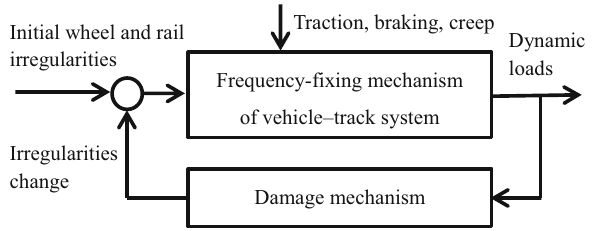
Fig. 20 Formation process of wheel polygonal wear (modified after